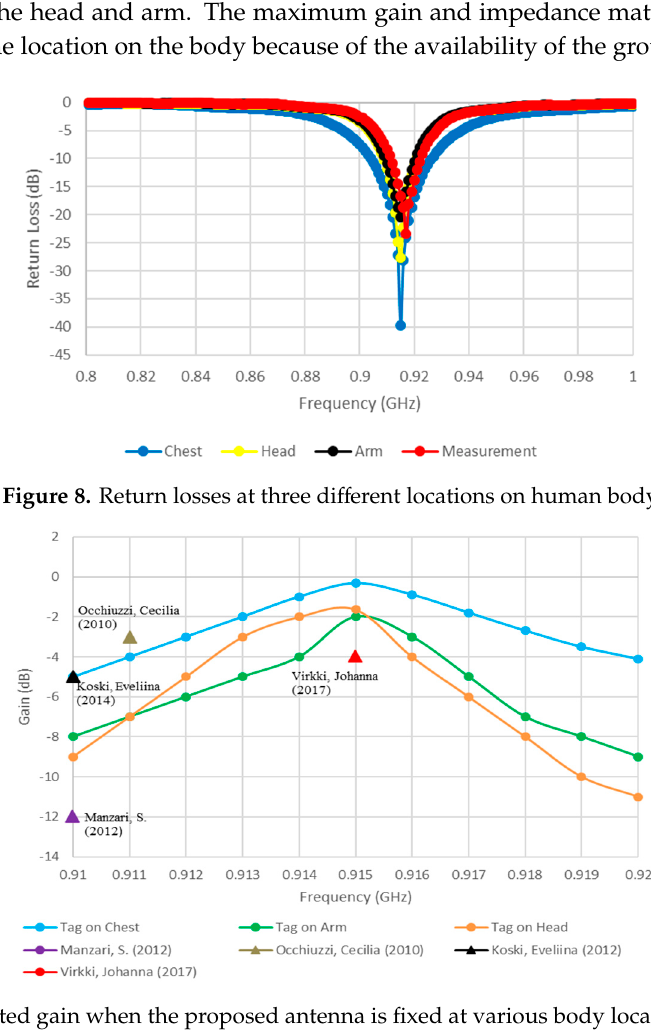
Figure 9. Simulated gain when the proposed antenna is fixed at various body locations compared to earlier studies.